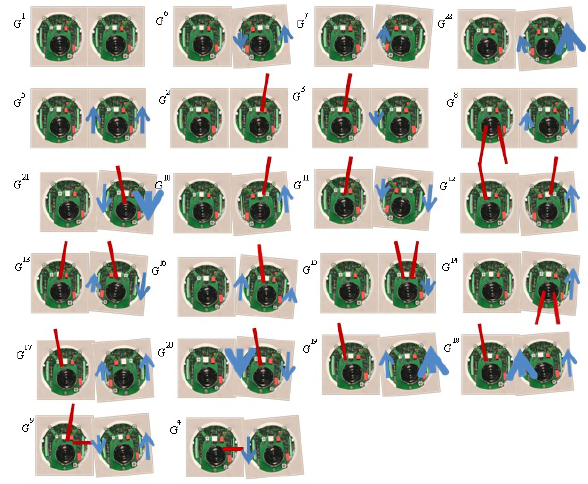
Figure 11: Pictorial representation of generated achievement goals in the first run of experiment 1. Each goal has a ‘before’ and ‘af- ter’ picture. Blue arrows indicate change in wheel speed (higher or lower speed). Red lines indicate change in sensor status (to detect- ing or not detecting). Change in orientation of image, indicates goal change in orientation of robot.